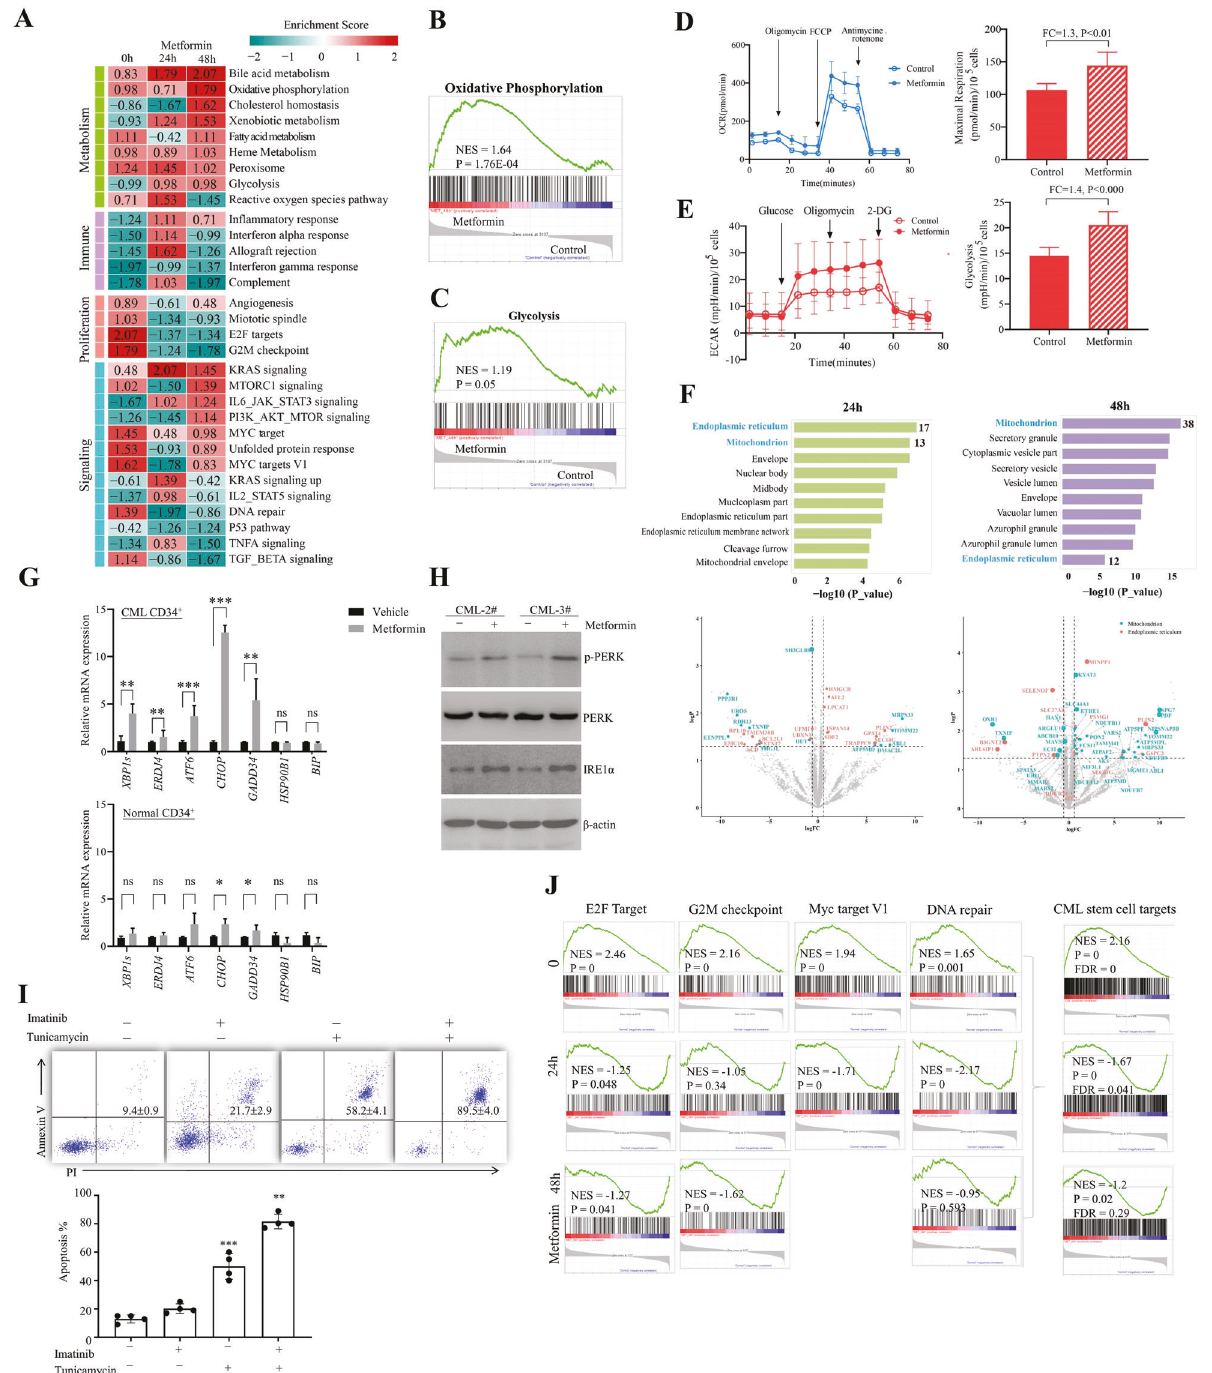
Fig. 4 Mechanism of metformin on CML CD34 + cells. A Puri fi ed CML CD34 + cells were treated with metformin for 24 and 48 h and subjected to label-free quantitative MS analysis. Heatmap of alternation pathways regulated by metformin was shown. B , C Representative GSEA plots of oxidative pathway and glycolysis post metformin treatment 48 h. D , E OCR and ECAR of CML CD34 + cells in response to metformin. F GO cell compartment (CC) enrichment analysis and volcano plots of proteins regulated by metformin for indicated times (FC > 1.5 and P < 0.05). G , H RT-PCR ( G , n = 3) and western blot analysis ( H ) of ER stress signaling of metformin or vehicle-treated puri fi ed CML or normal CD34 + cells. *, **, and *** indicated P value< 0.05, <0.005, and <0.001, respectively. I Puri fi ed CML CD34 + cells were treated with imatinib, tunicamycin or tunicamycin plus imatinib for 72 h. Cell apoptosis were measured. Representative fl ow cytometry plots were shown on the top. n = 4. ** and *** indicated P value <0.005 and <0.001 versus non-treated group, respectively. J GSEA plots of E2F target, G2M checkpoint, MYC target, DNA repair, and combined protein subset named CML stem cell targets are